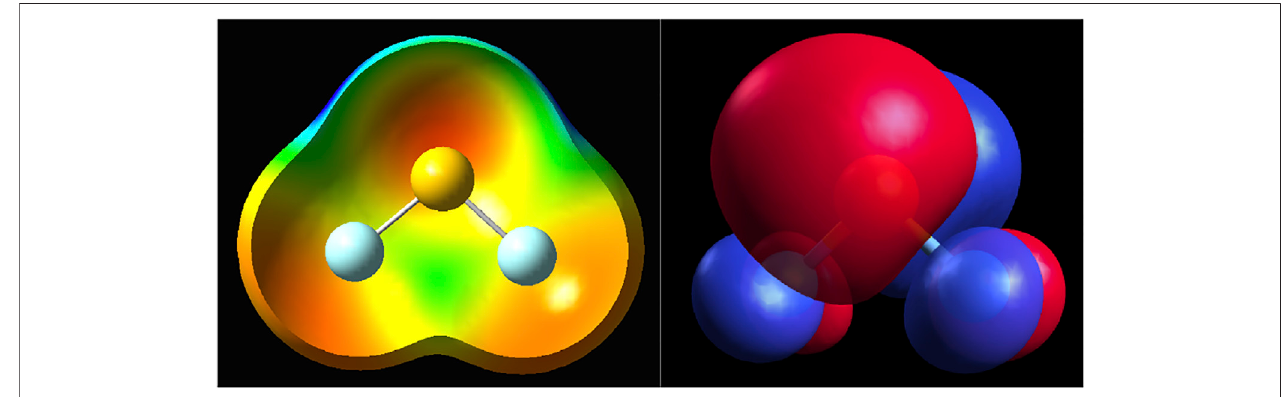
FIGURE 8 | SF 2 : The electrostatic potential mapped on the density surface of 0.001 au threshold (left); HOMO orbital (right) from DFT TPSS